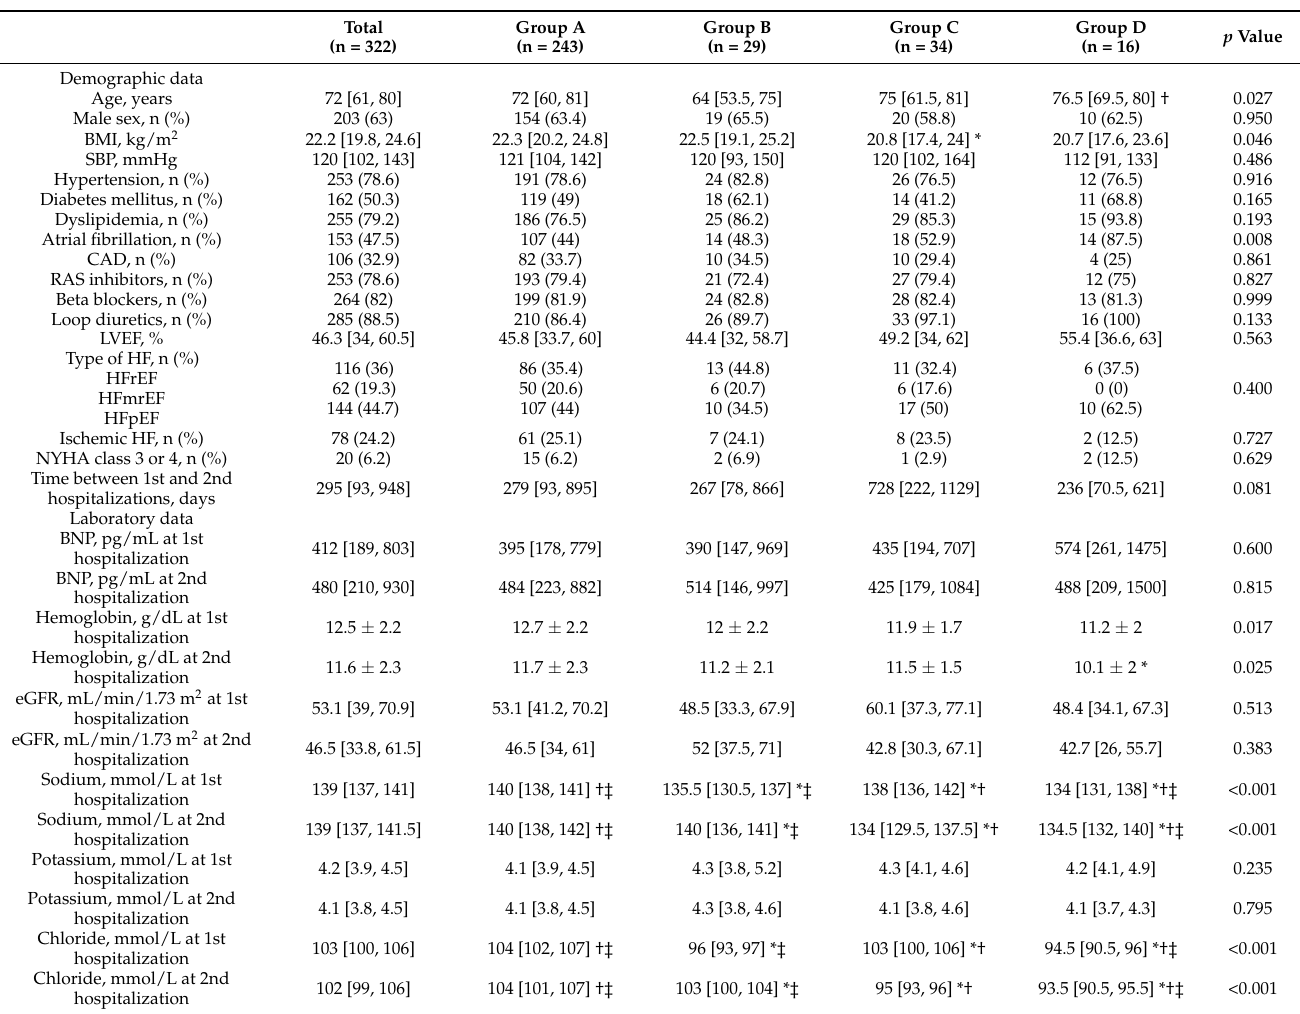
Table 1. Patient